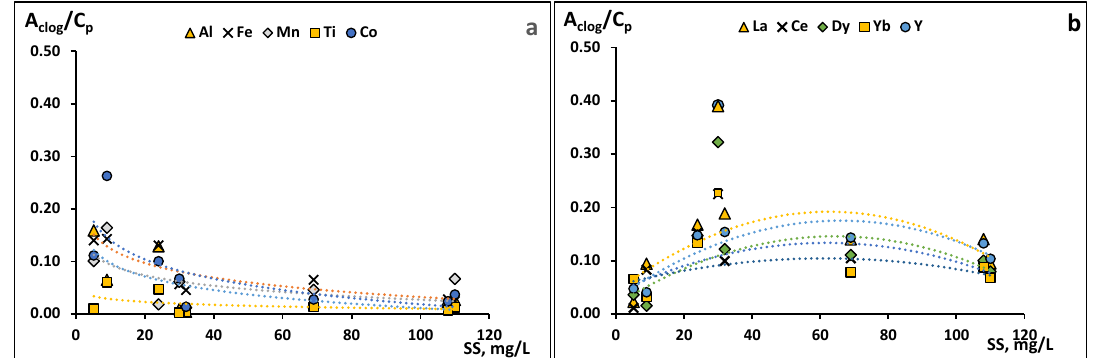
Figure 8. ( a ) Share of clogging in the concentration of particulate forms of elements at the different suspended solids content in river waters for the Fe, Al, Ti, Mn, Co; ( b ) the same for the Y and REEs.